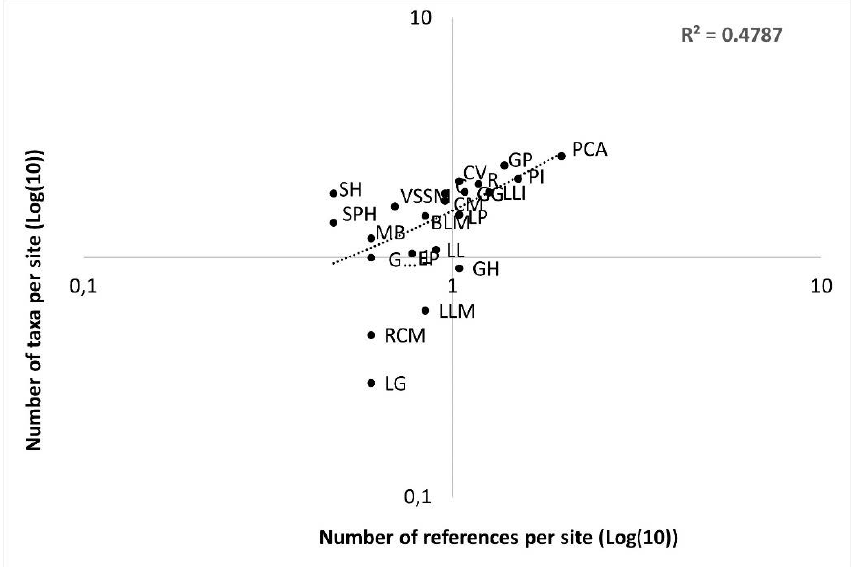
Figure 4. Log-Log correlation between the number of reported taxa and the number of references per site.